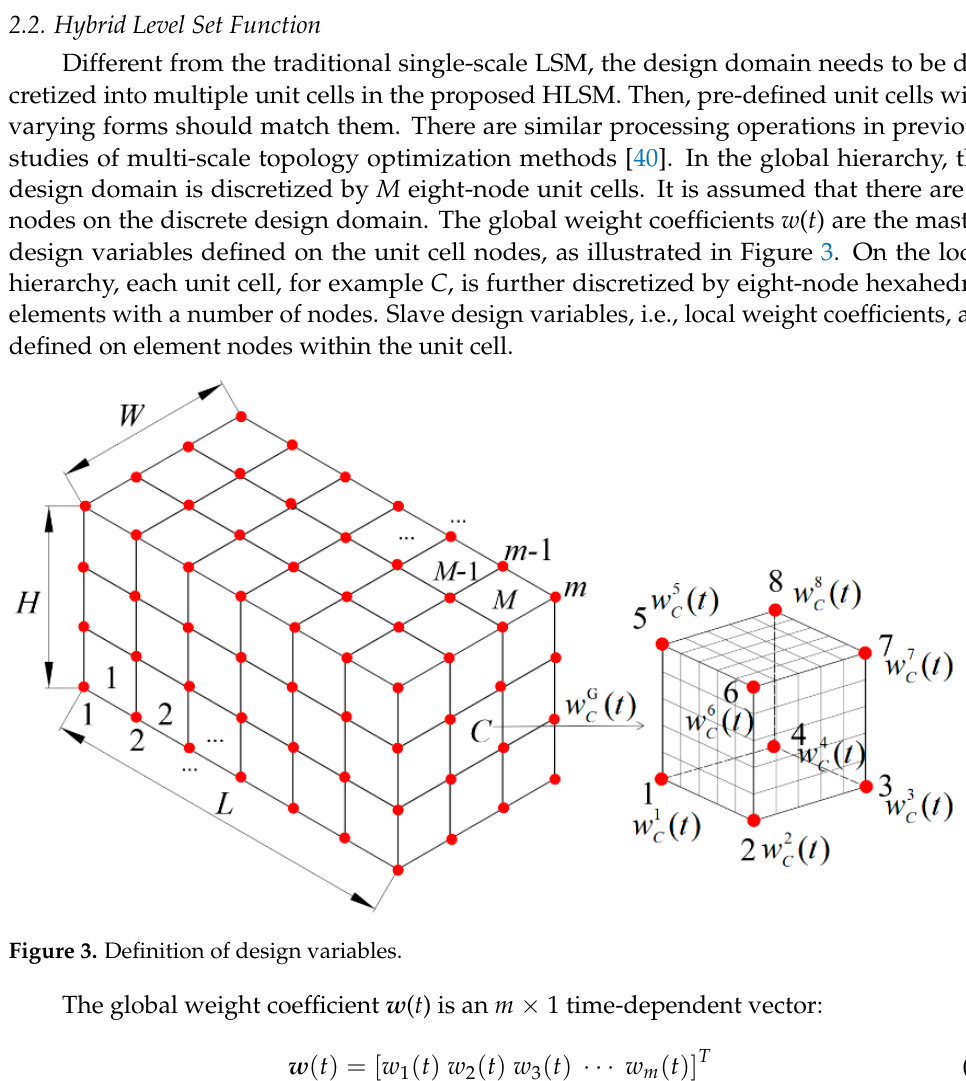
Figure 3. Definition of design variables.